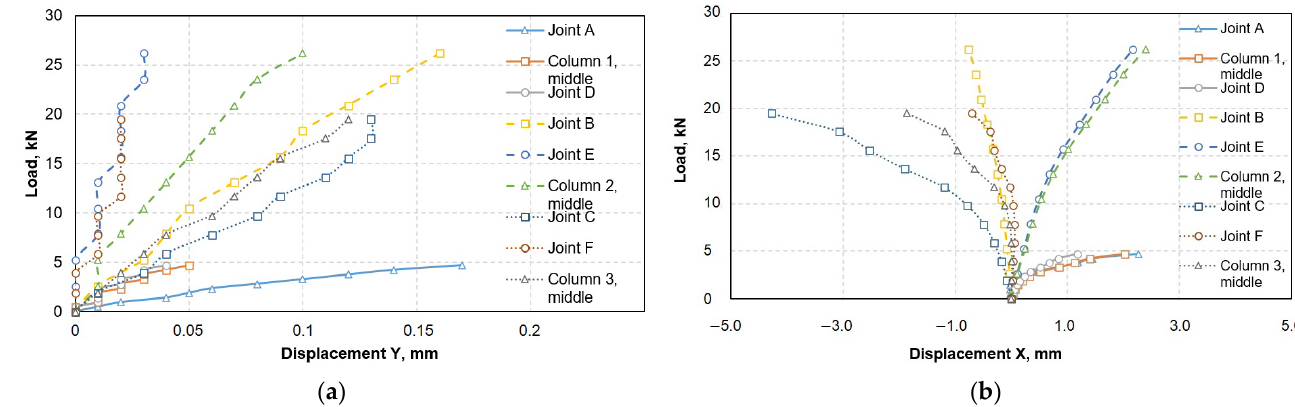
Figure 6. Loading graph for upper joints of the frame in the first stage of simulation ( a ) and displacement control points ( b ).